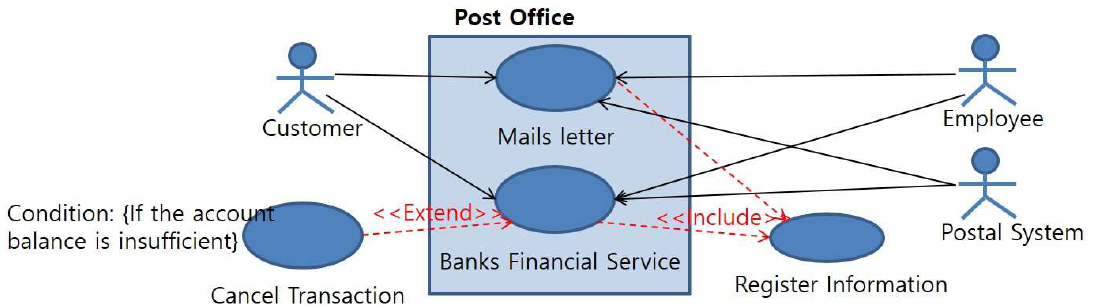
Figure 14. Inclusion and extension relationship.